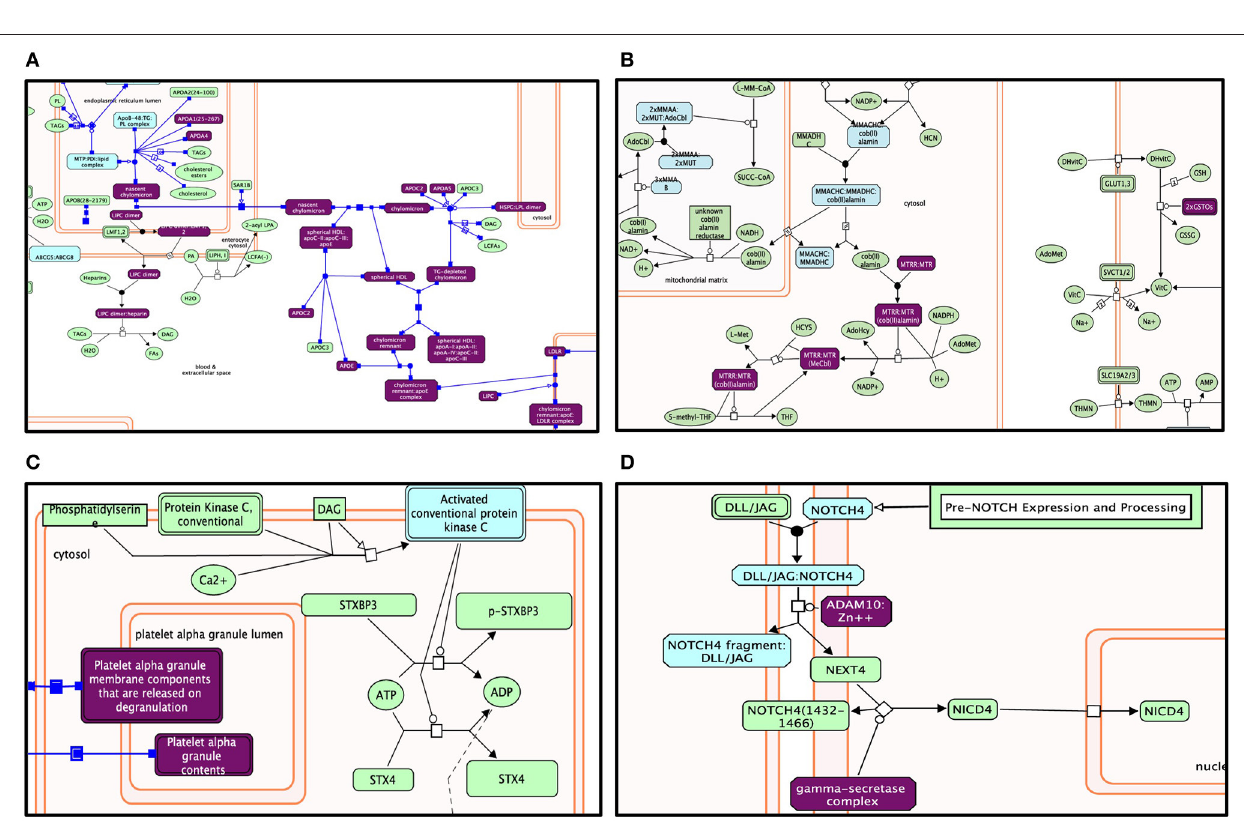
platelet cytosolic Ca 2 + ( Figures 5C , 6C ). Pathway enrichment results for NOTCH signaling showed positive AD genes associated with pre-NOTCH expression and processing,